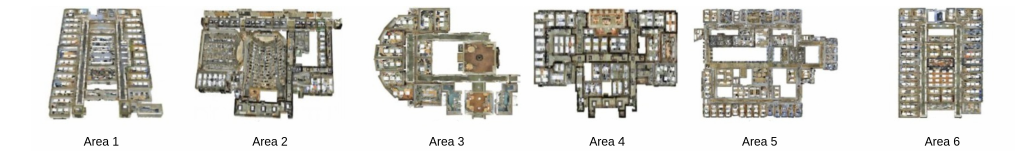
Figure 3. S3DIS dataset